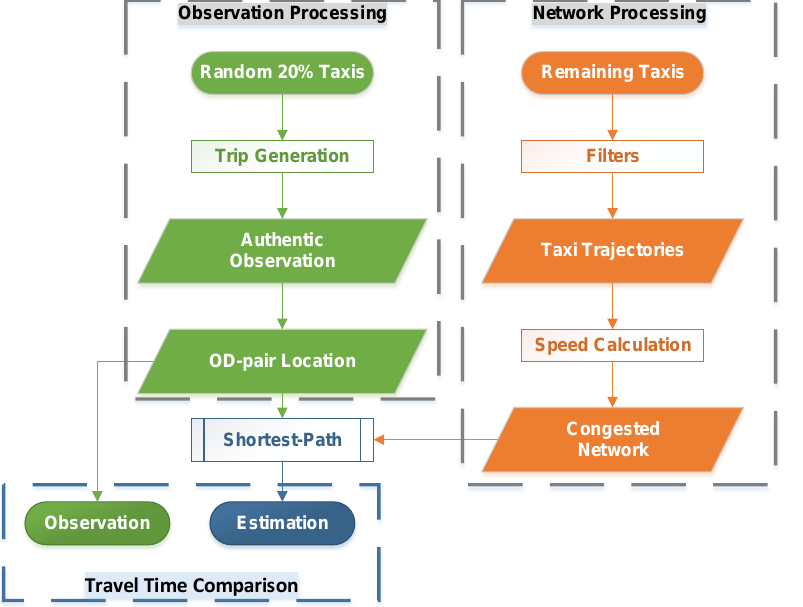
Figure 8. Flow chart of validation process The process is illustrated in Figure 8. From the 10,357 taxis forming the dataset for the 4th February (Monday), 20% are randomly selected and their trajectories combined to form an observational dataset. The trajectories from the remaining eighty per cent of taxis are combined to form an experimental dataset which is used to generate congested link speeds. Then the travel time from estimated shortest-path and observed trip duration will be compared.